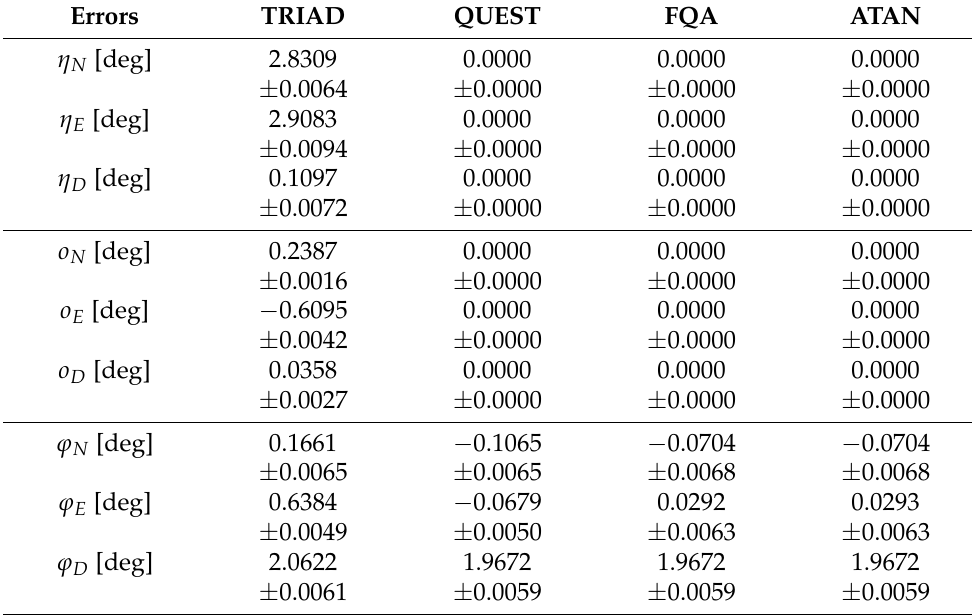
Table 6. Estimated DCM normality, orthogonality, and alignment errors at the completion of the experimental test and associated standard